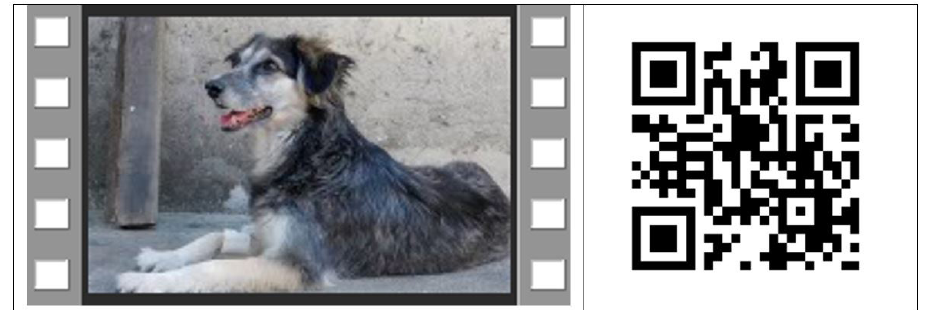
Figure 1. Therapeutic diagnosis and clinical evolution of a dog suspected of having acquired myasthenia gravis. Scan the QR code to watch the